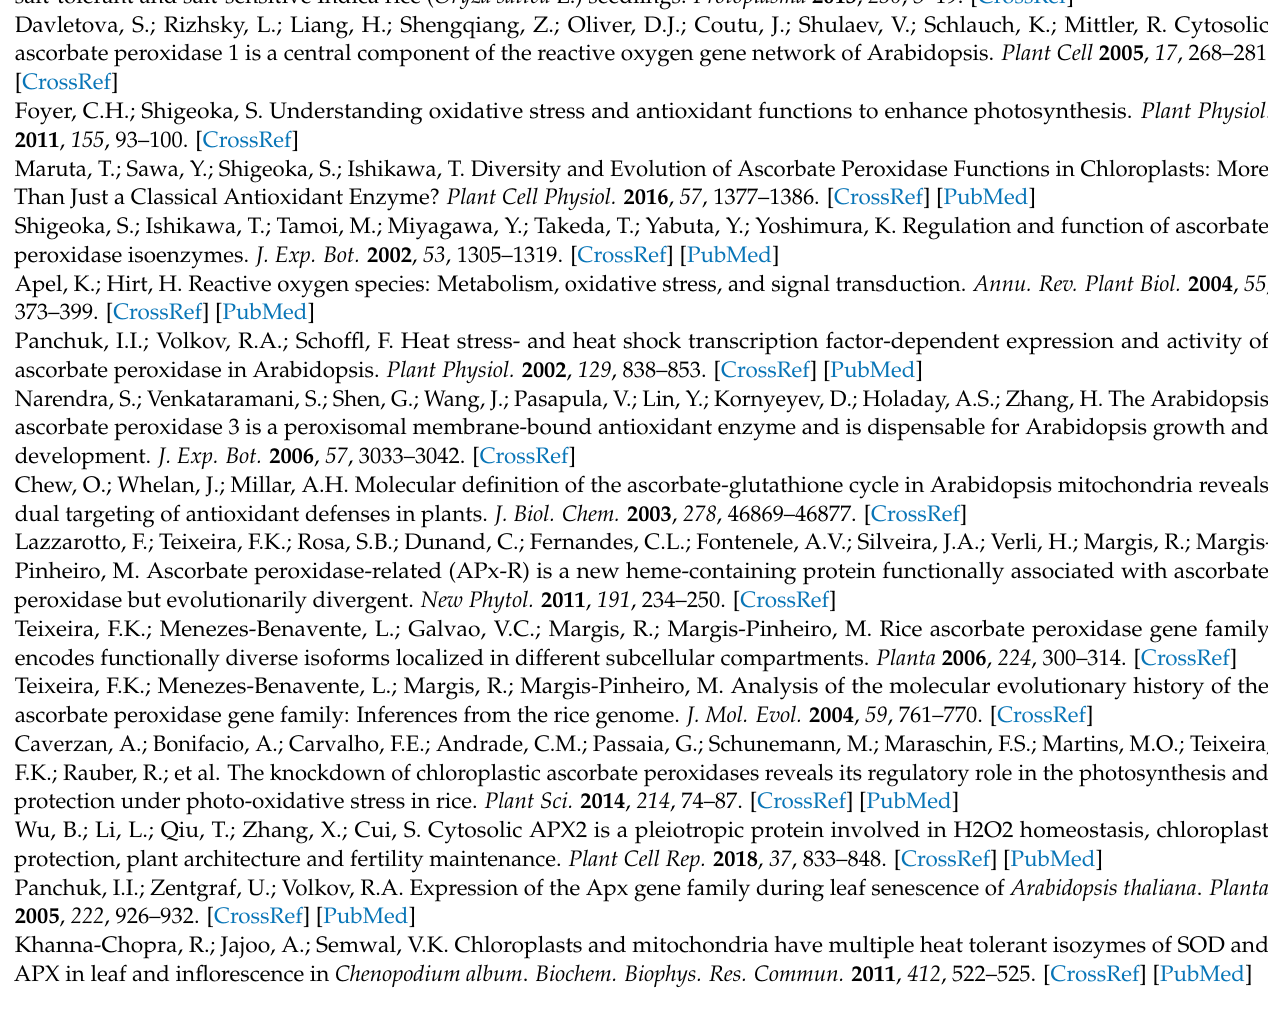
RT-qPCR. Table S3: Motif sequences of PtrAPX genes. Table S4: Secondary structure of the PtrAPX proteins. Table S5: GO annotation of the PtrAPX genes. File 1: The accession numbers and amino acid sequences of P. trichocarpa , Arabidopsis and rice. File 2: The templates and PDB files of each